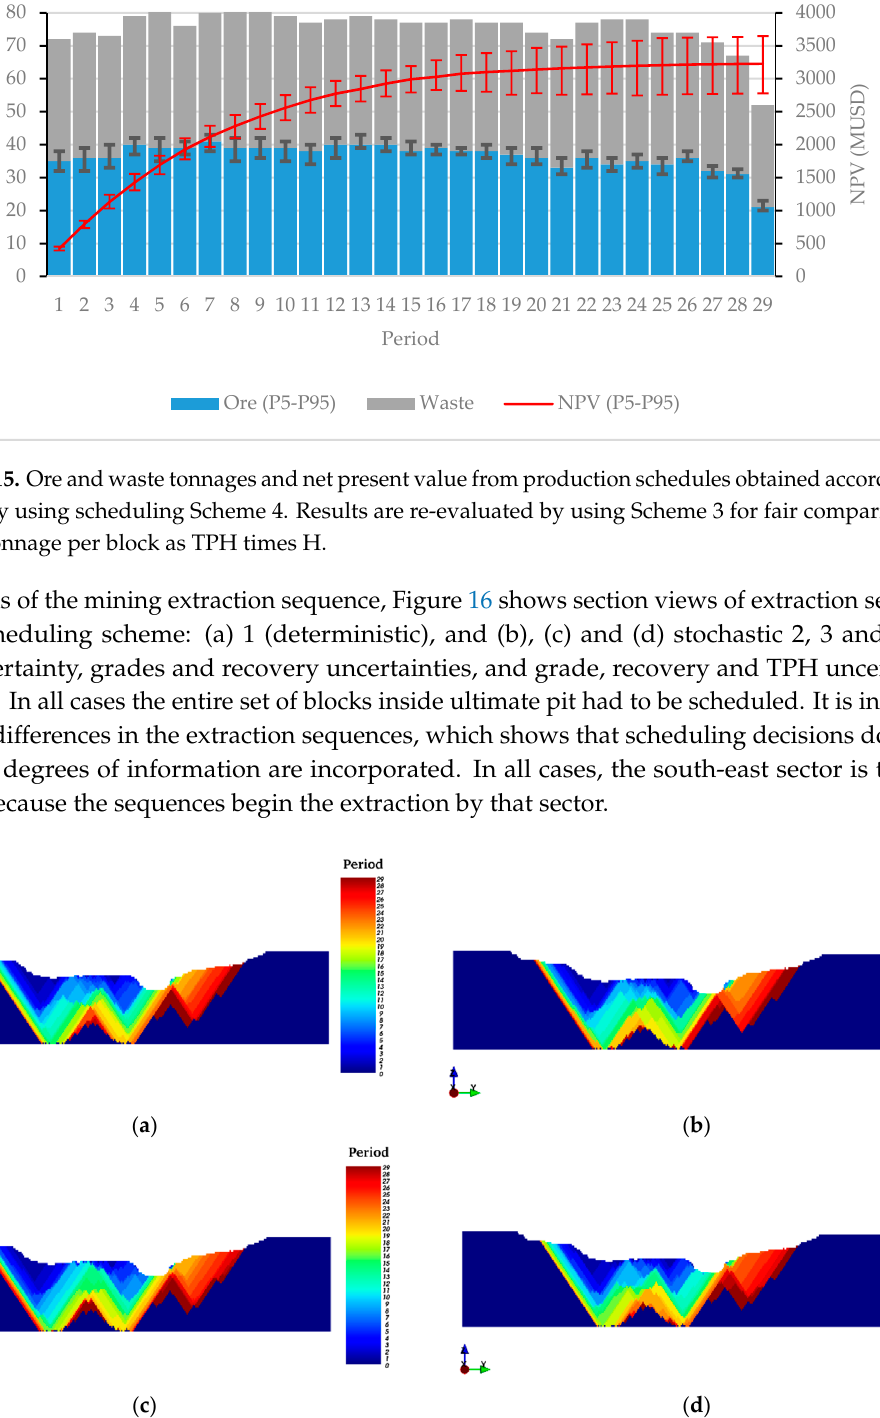
Figure 16. S-N sections, E views of the production schedules obtained by each scheduling scheme on 90% probability ultimate pit obtained by using Scheme 3. ( a ) Scheduling Scheme 1; ( b ) Scheduling Scheme 2; ( c ) Scheduling Scheme 3; ( d ) Scheduling Scheme 4.